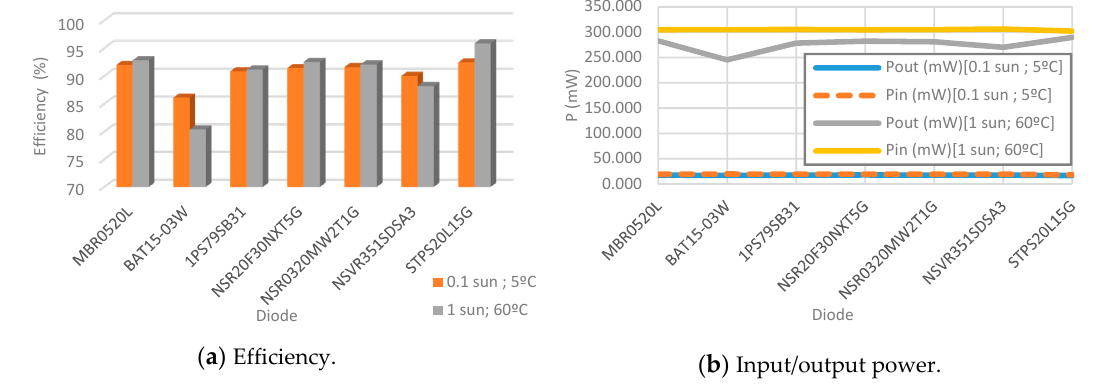
Figure 11. Comparisons between diodes at 0.1 sun and 5 °C; and 1 sun and 60 °C.